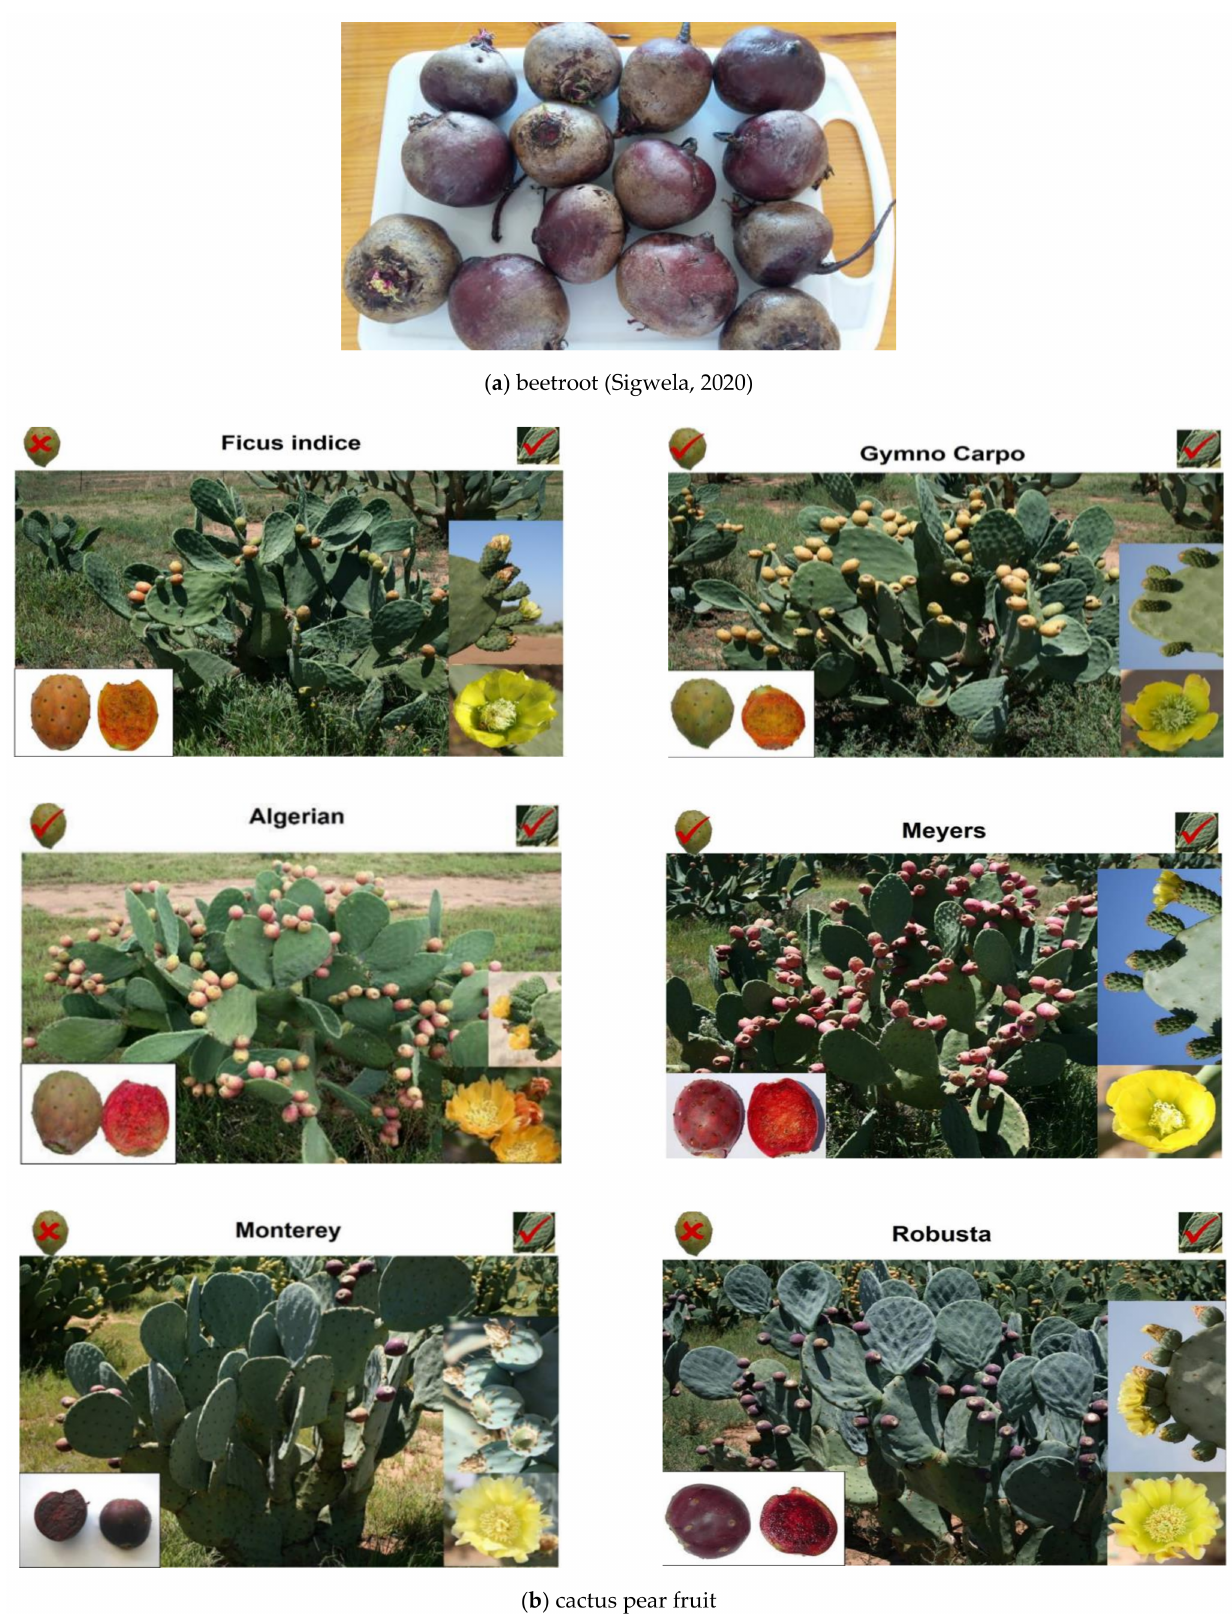
Figure 4. Beetroot samples ( a ) and cactus pear cultivars with different fruit colours ( b ) (courtesy of Dr. H.